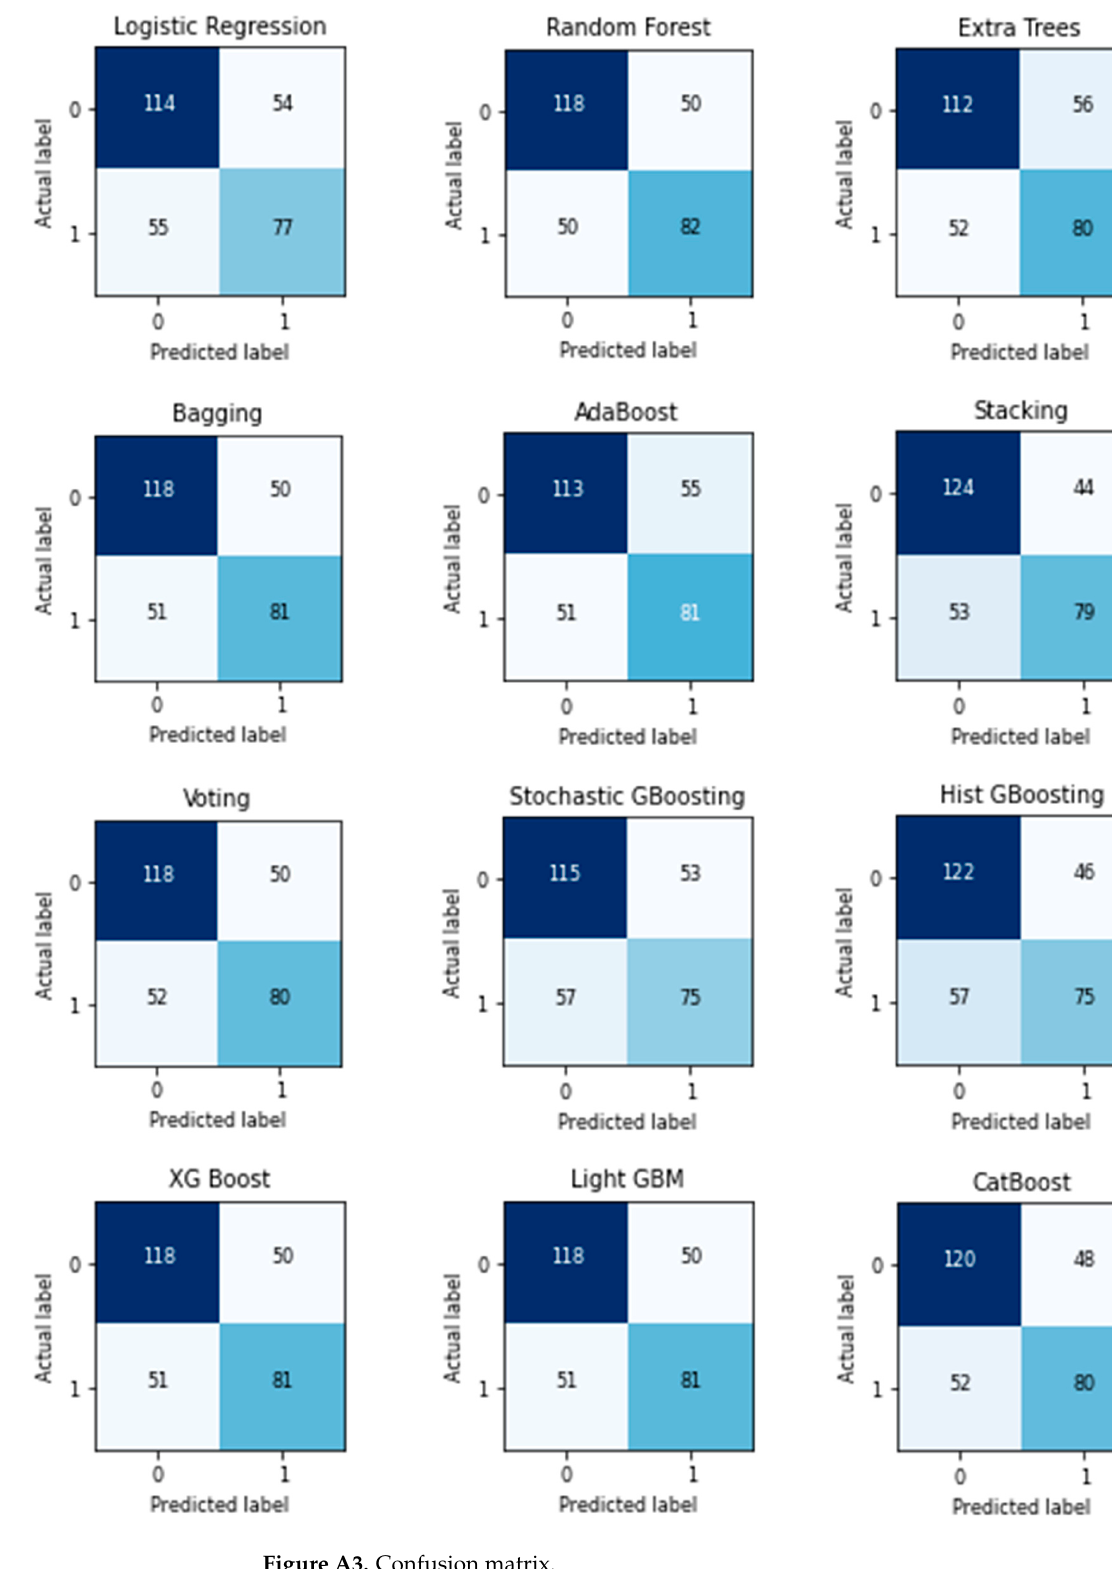
Figure A3. Confusion matrix.